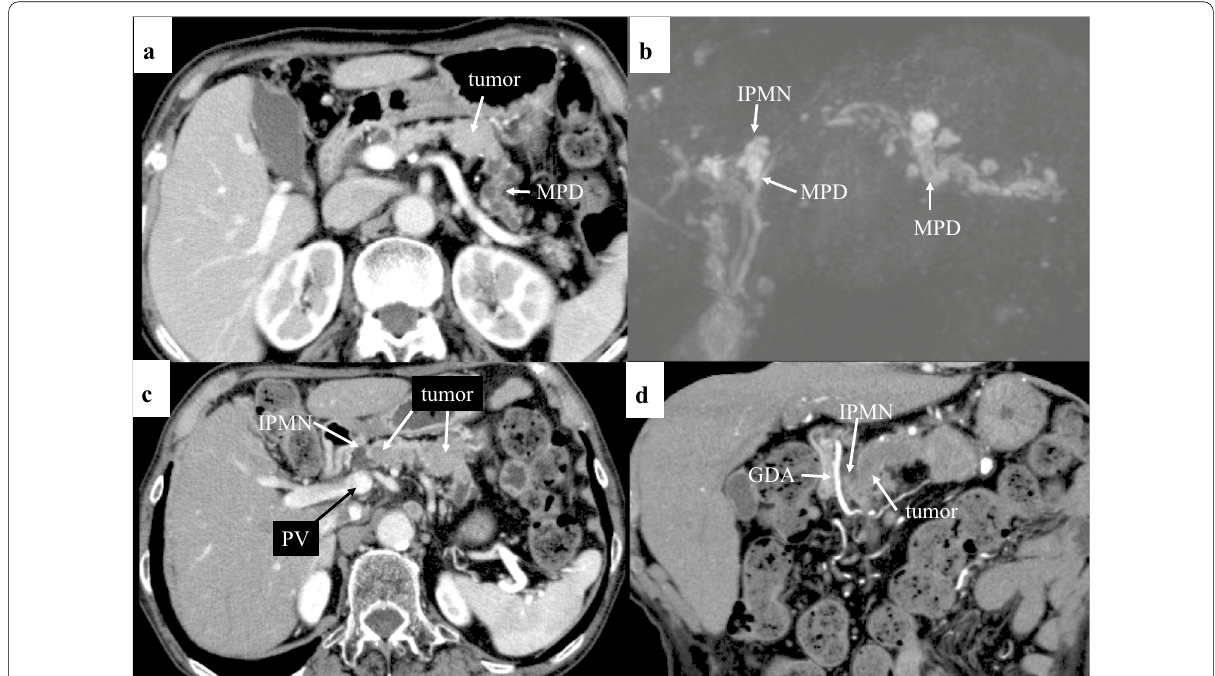
Fig. 1 a Multi-detector row computed tomography (MDCT) shows a slightly enhanced round tumor and the dilated caudal main pancreatic duct (MPD). b Magnetic resonance cholangiopancreatography (MRCP) demonstrates mild dilatation of cranial MPD and severe dilatation of caudal MPD. Cystic lesion [suspicious intraductal papillary mucinous neoplasm (IPMN)] is visible in the neck of the pancreas. c MDCT shows a tumor with downstream progression until the left side of IPMN. d A coronal view shows intraductal tumor mass extends to the left side of the